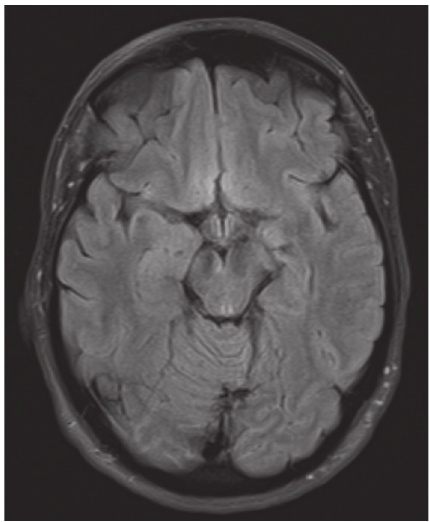
Figure 3: Axial FLAIR MRI showing injury in the medial aspect of the right cerebral peduncle close to the root entry zone of the right third nerve.